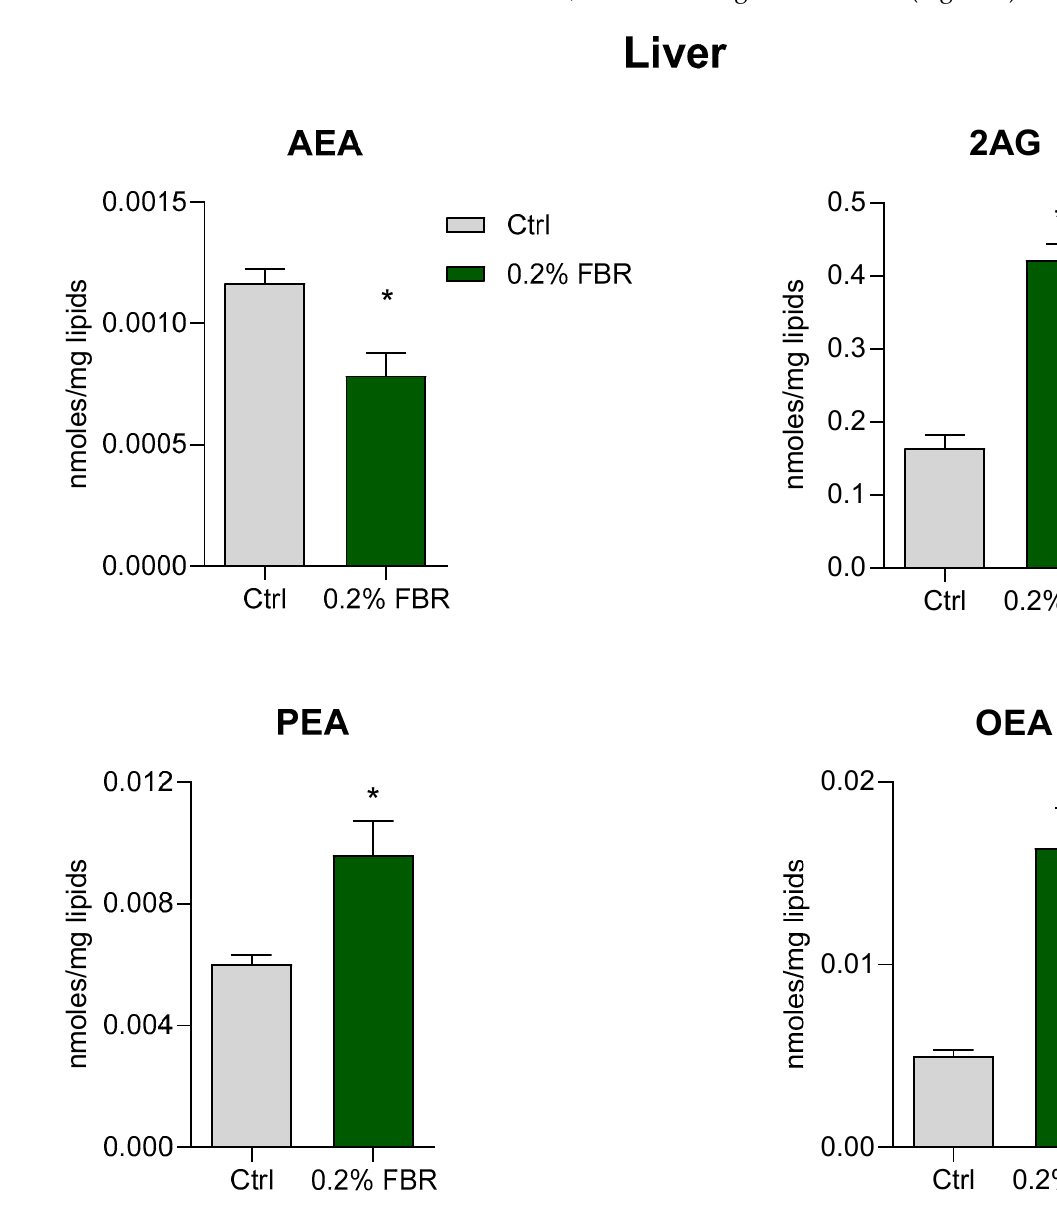
Figure 4. Hepatic levels of the endocannabinoids (eCB), arachidonoylethanolamide (AEA) and 2‑arachidonoylglycerol (2‑AG), and the eCB‑like molecules, palmitoylethanolamide (PEA) and oleoylethanolamide (OEA), in mice fed a control diet (Ctrl) or a 0.2% fenofibrate‑supplemented diet (0.2% FBR). Data are expressed as nmoles/mg of lipids and represent the mean ± SEM of n = 5. * p ≤ 0.05; ** p ≤ 0.01.